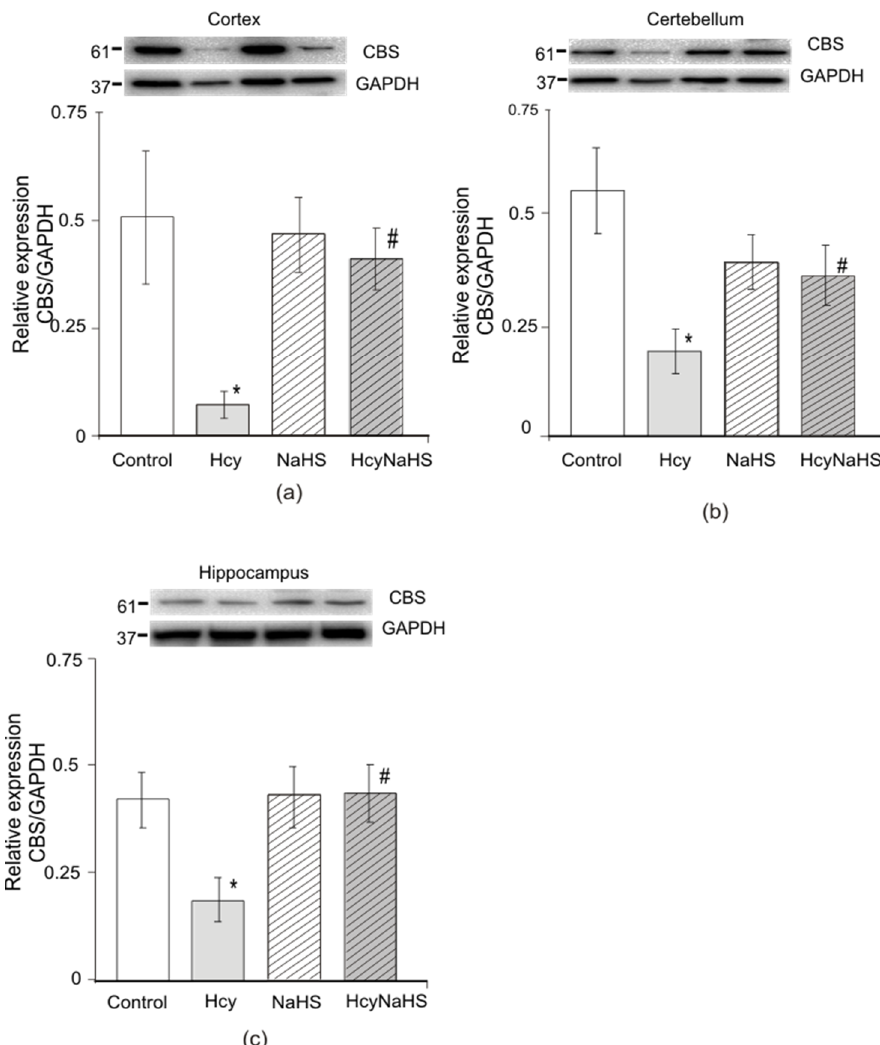
Figure 8. Effects of NaHS administration on the expression of CBS in cortex, cerebellum, and hippocampus of rats with maternal hHcy. Representative Western blot images for CBS and GAPDH proteins in different groups of rats (upper panel) and its quantification (bottom panel) in cortex ( a ), cerebellum ( b ), and hippocampus ( c ) of rats from control, Hcy, NaHS, and HcyNaHS groups after normalization to housekeeping protein GAPDH. * p < 0.05 compared to control, # p < 0.05 compared to the Hcy group.